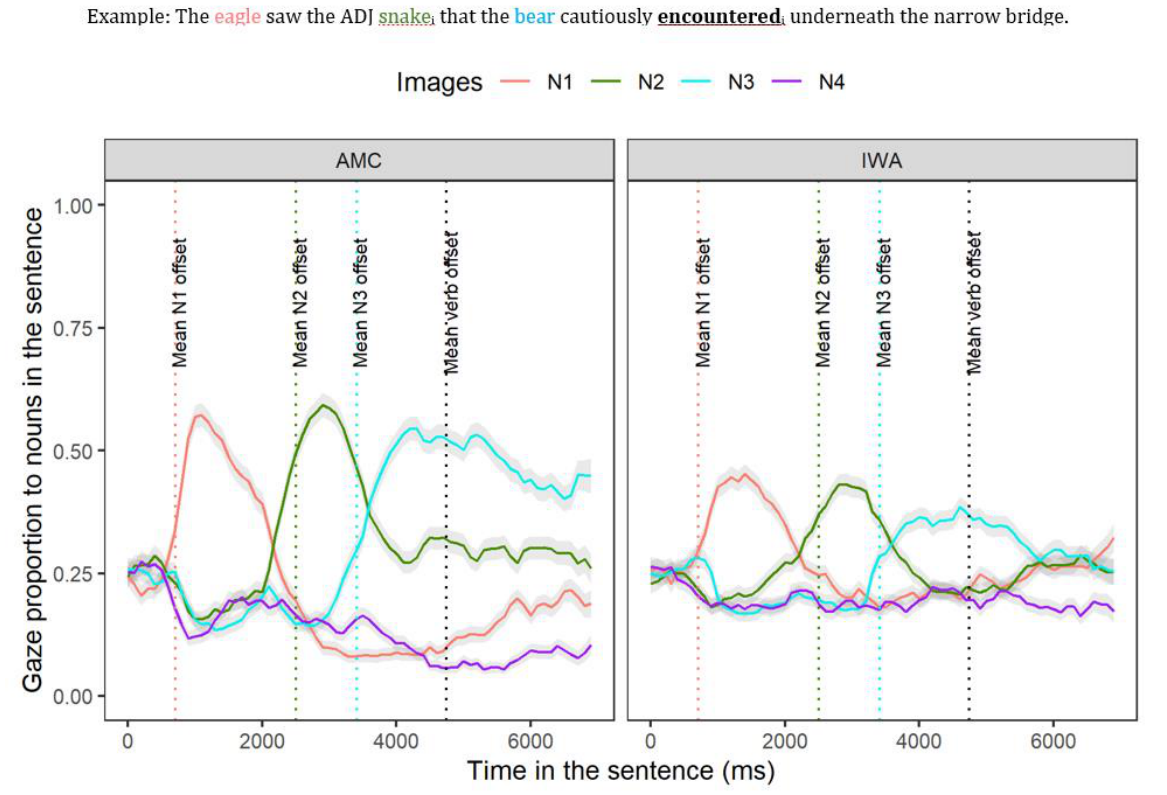
Figure 4. Mean gaze over time toward N1 (first noun, solid salmon line), N2 (second noun, solid green line), N3 (third noun, solid blue line), and a distractor image (solid purple line) averaged across conditions for each group which begins at the auditory onset of the sentence (N1), N4 (unrelated noun, purple line). Shaded areas represent 95% confidence intervals within subject. The dotted salmon line represents mean offset N1; the dotted green line represents mean offset N2; the dotted blue line represents mean offset N3; the dotted black line represents mean offset of the